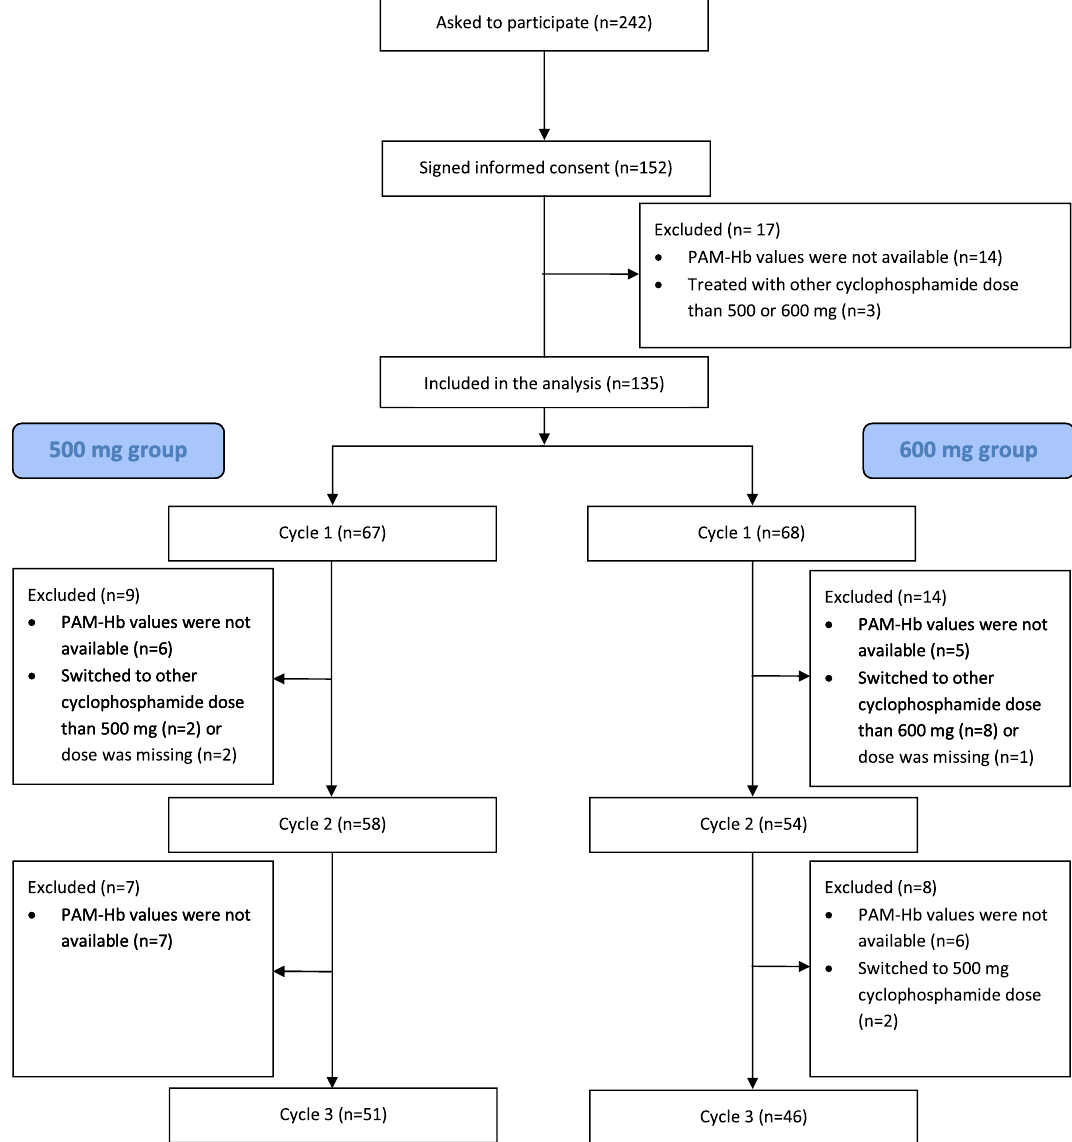
Figure 1. Flowchart of breast cancer patients included in the TailorDose I study, based on given dose of cyclophosphamide per body surface area during three treatment